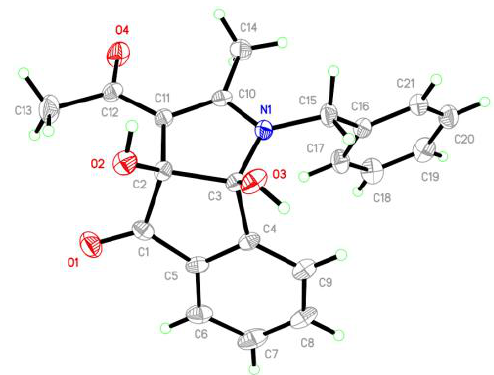
Figure 3. The crystal structure of 8f.